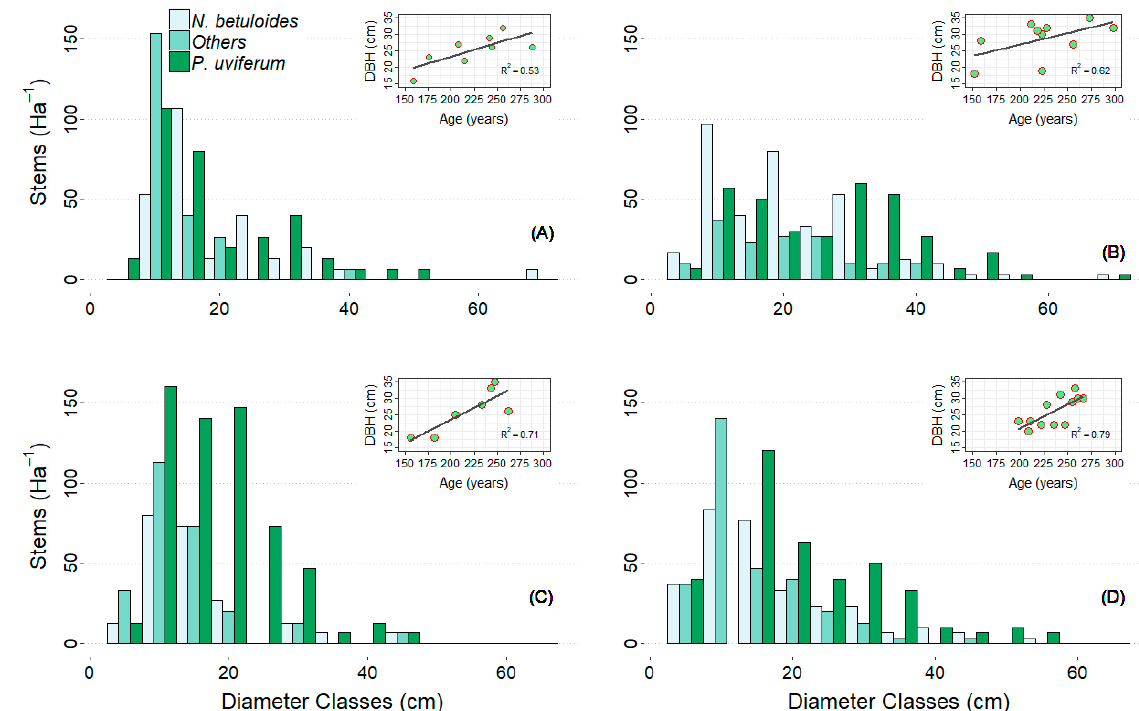
Figure 2. Diameter distribution and age diameter relationship per stand (inside panels). In ( A ) Stand 1, ( B ) Stand 2, ( C ) Stand 3, and ( D ) Stand 4.